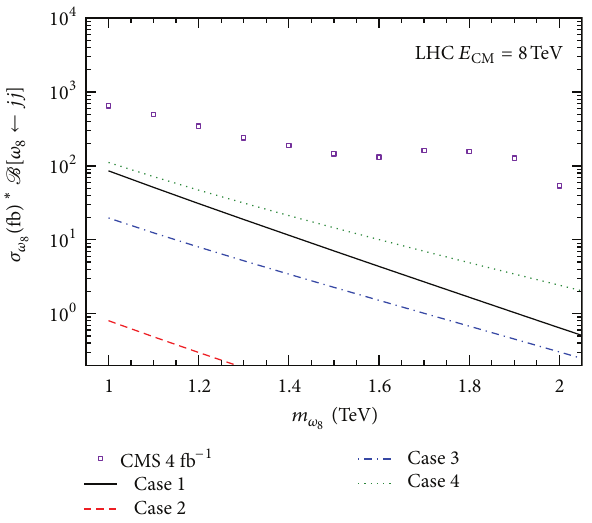
Figure 13: Production cross-section times branching ratio for 𝜔 8 into dijets, for the four parameter sets at the LHC 8TeV. CMS upper limit [38] for the cross-section of dijet resonance production is also plotted.